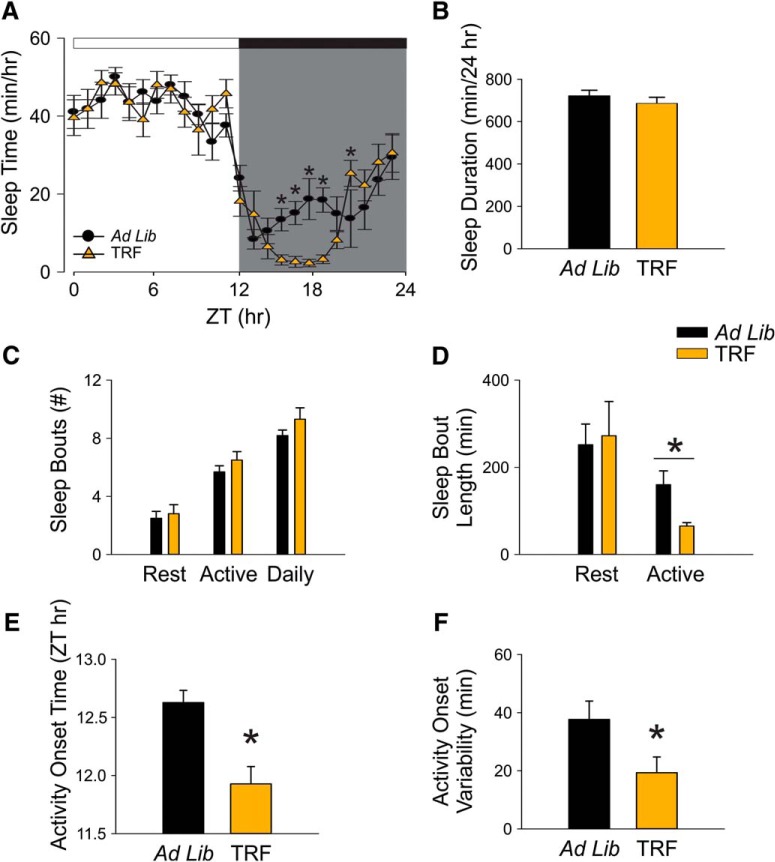
TRF prevented disease-caused awakening time without altering the amount of sleep behavior. Video recording in combination with automated mouse tracking analysis software was used to measure immobility-defined sleep. A, Running averages (1-h window) of immobility-defined sleep in Q175 mutants with ad lib (black) and timed feeding (orange) are plotted. The white/black bar on the top of wave form indicates the 12/12 h LD cycle. B–F, Quantification of the immobility-defined sleep rhythms. The temporal sleep wave form was analyzed using a two-way RM ANOVA with time and treatment as factors. Other comparisons between Q175 cohorts were made using a t test. Asterisks represent significant differences due to TRF regimen compared to ad lib controls (p < 0.05); n = 8/group.